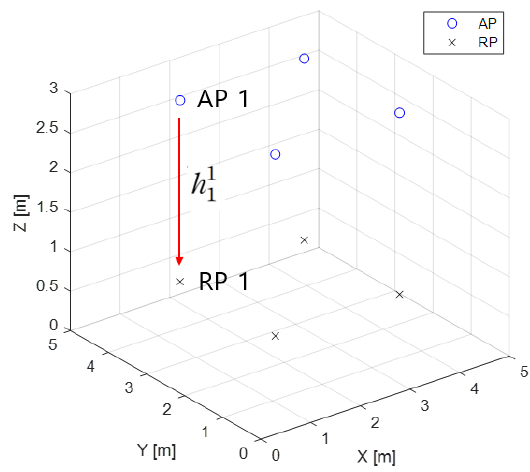
Figure 6. Concept of fingerprinting DB measurements.